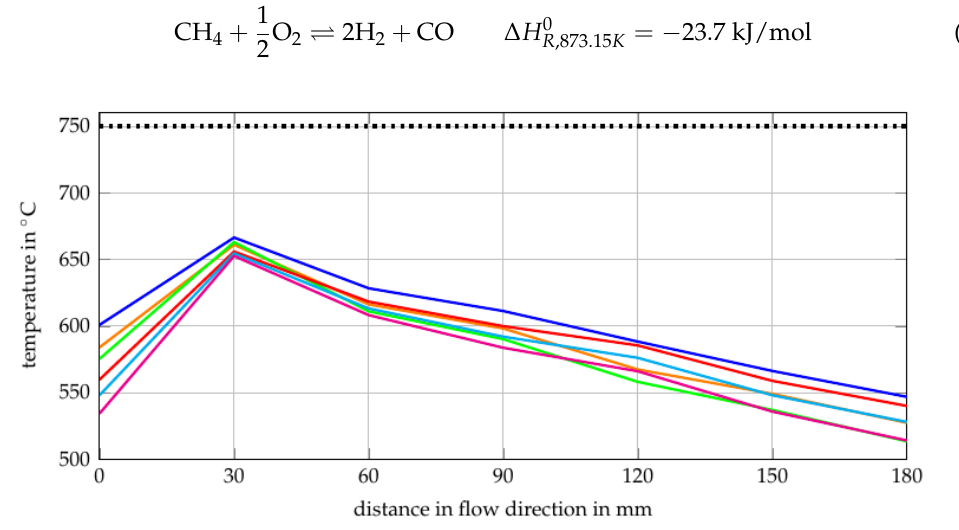
Figure 7. Temperature profile along the reaction zone of the reformer for gas composition 1 , gas composition 2 , gas composition 3 , gas composition 4 , gas composition 5 , gas composition 6 , reformer simulation